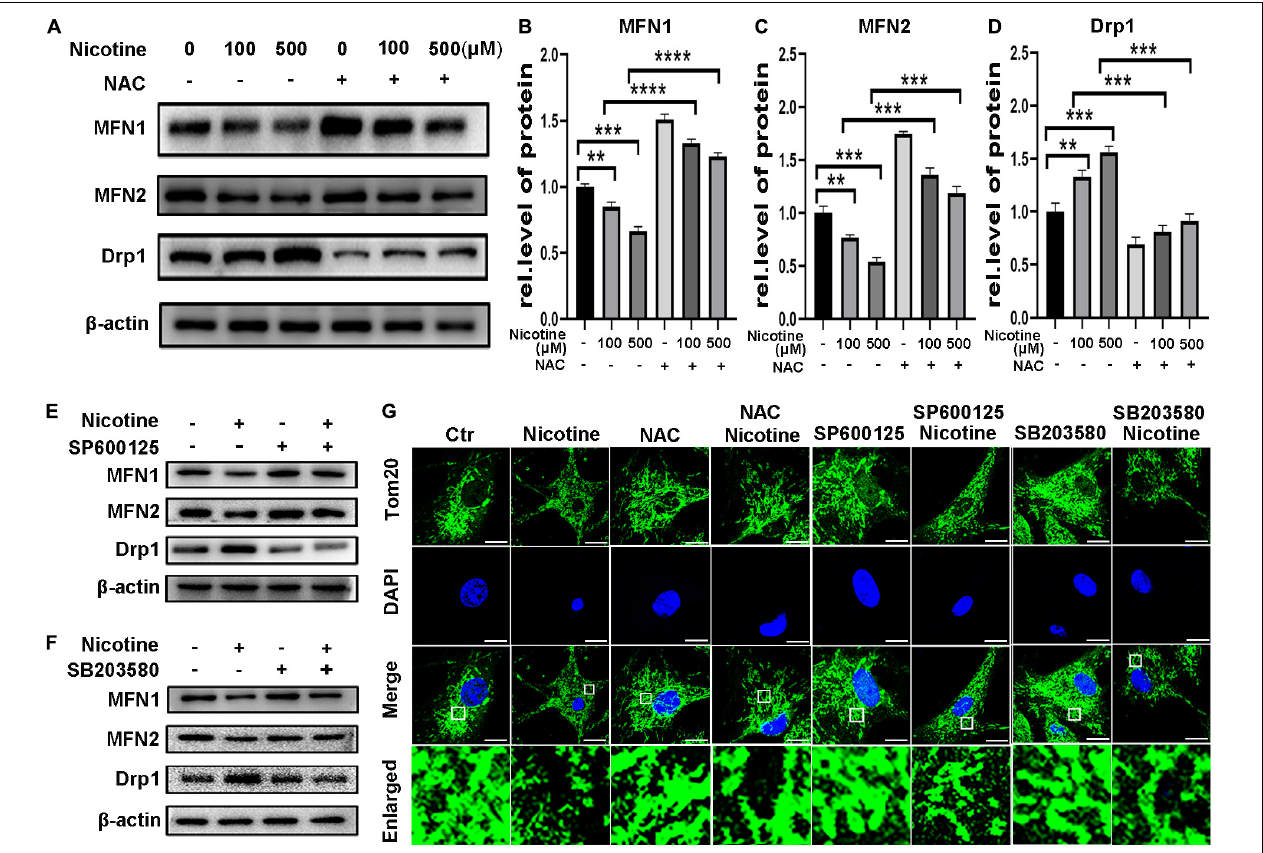
FIGURE 5 | Nicotine induced mitochondrial dynamics disorder through ROS mediated p38/JNK pathway. (A) Protein levels of mitochondrial dynamics factors with NAC pretreatment. (B–D) Results were analyzed by Image J. (E,F) Pre-treatment of SP600125 and SB203580 alleviate mitochondrial dynamics disorder, which shown by western blotting. (G) Mitochondrial morphology was observed by Laser confocal microscopy imaging system with pretreatment of NAC, SP600125 and SB203580 in NRVMs (Scale bar = 10 µ m). (**** p < 0.0001; *** p < 0.001; ** p < 0.01, n = 3).